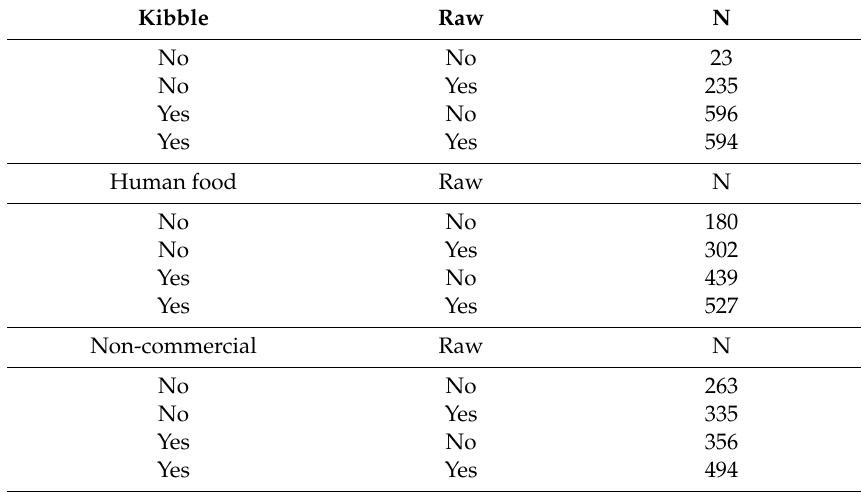
Table 4. Number of dogs fed with di ff erent combinations of raw and other food types. Figure 4. The association between feeding uncooked or raw food and the body condition of the dog.